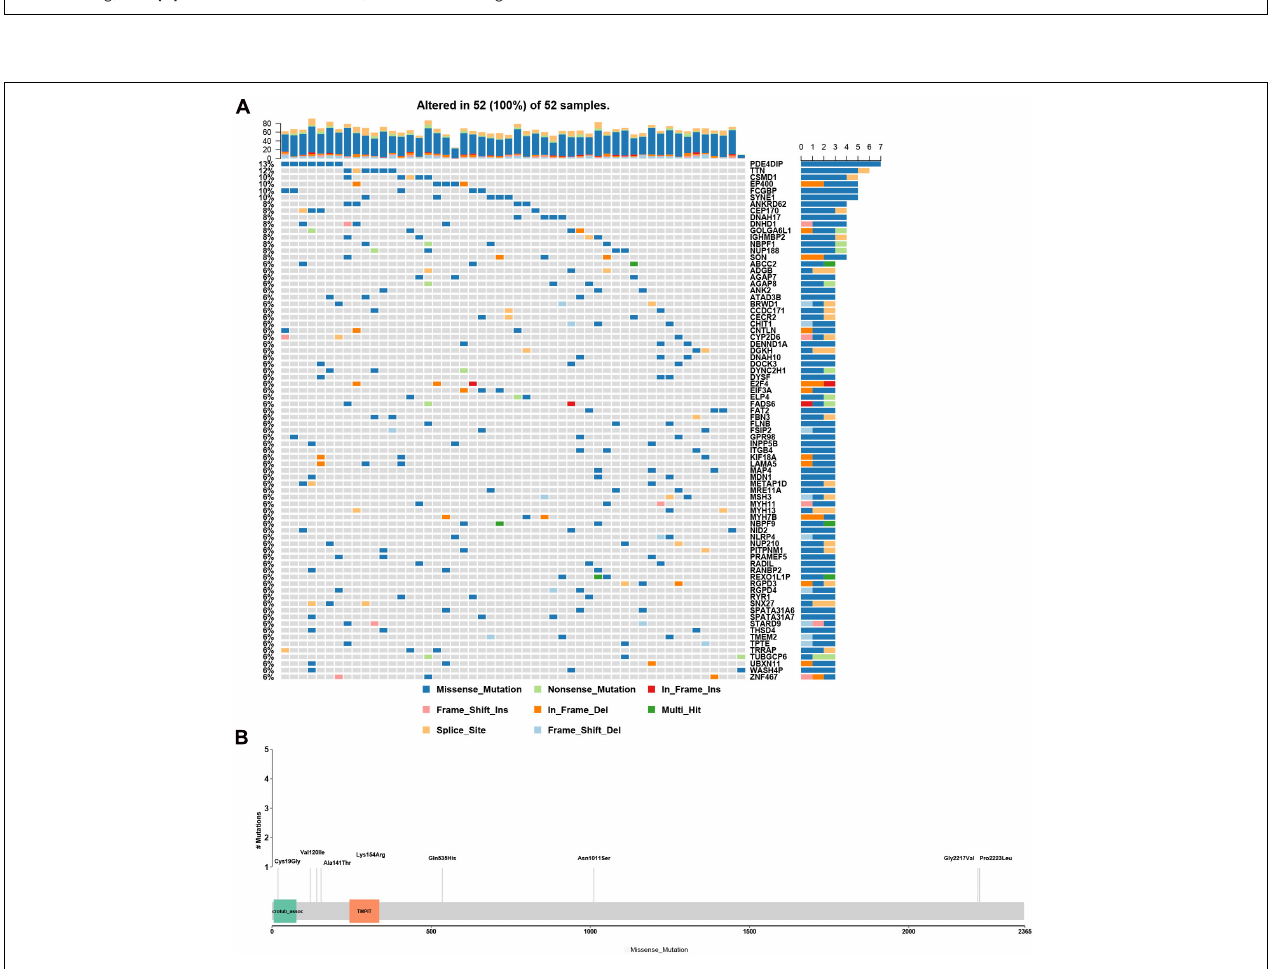
FIGURE 3 | Analysis of rare, potentially causative mutations identified in the analyzed hemifacial microsomia (HFM) patient cohort. (A) List of genes found to harbor variants in > 2 patients, ranked by mutation frequency. (B) Details of mutations (p.Ala141Thr, p.Lys154Arg, p.Cys19Gly, p.Asn1011Ser, p.Val120Ile, p.Gln535His, p.Pro2223Leu, and p.Gly2217Val.) in PDE4DIP that exhibited the greatest number of mutations and was the most frequently mutated gene among the analyzed patients.